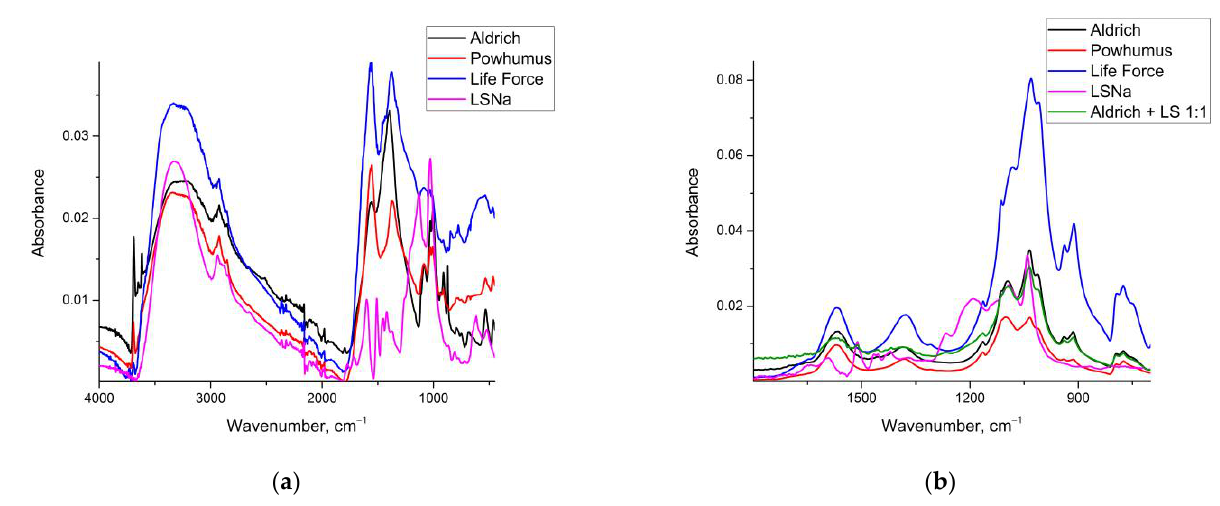
Figure 1. ATR absorption spectra of ( a ) lignosulfonate and humate powders from Aldrich, Powhumus, and Life Force in the mid - IR region (4000–500 cm −1 ) and ( b ) aqueous solutions of lig- nosulfonate and the same humates, and a mixture of Aldrich with lignosulfonate in the mid - IR region (1800–700 cm − 1 ).